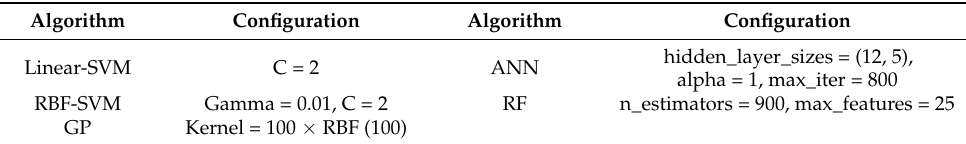
Table 2. Major parameters of ML models.